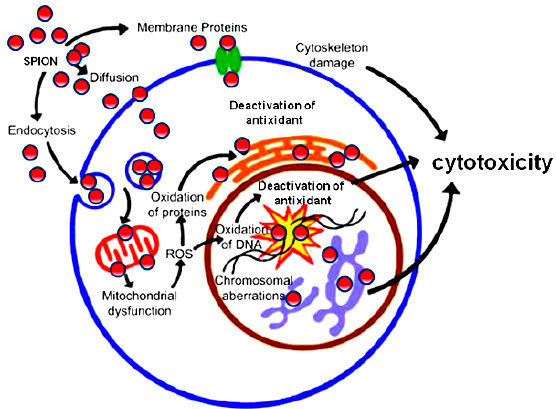
Figure 2. The main routes of nanoparticles (NP) entry into the cells and their subsequent intracellular mechanism(s) [24].